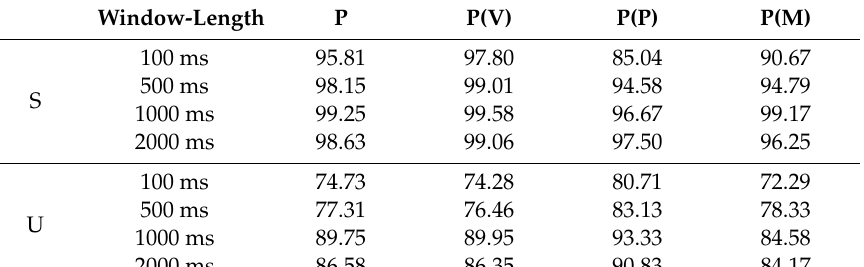
Table 5. Classification Results for VPM Scheme.